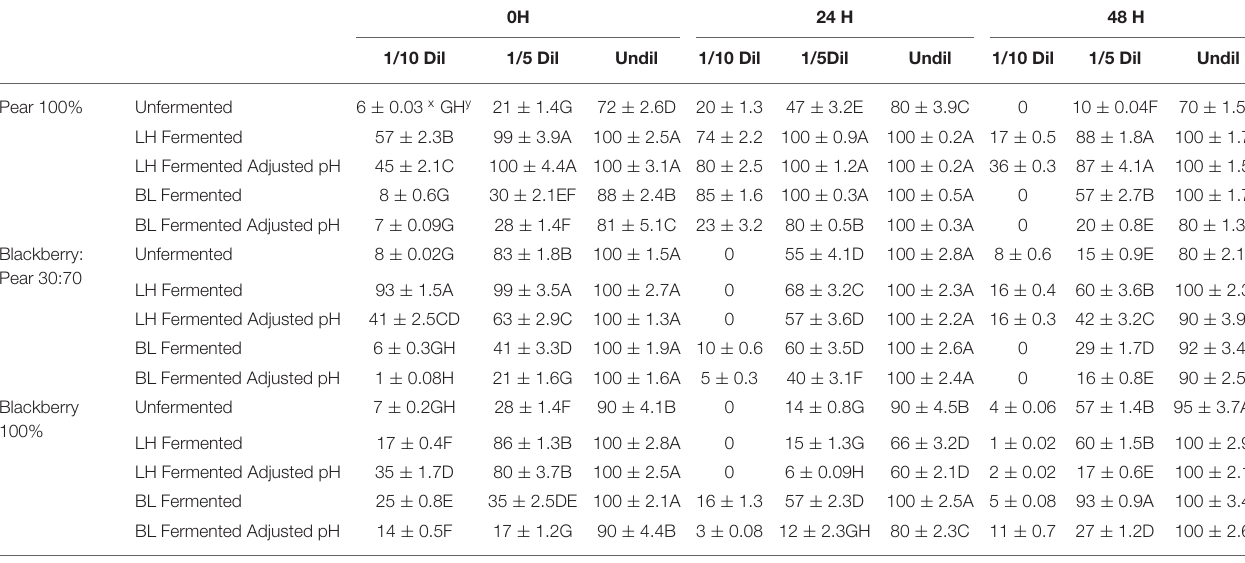
TABLE 3 | Anti-hyperglycemic property relevant α -amylase enzyme inhibitory activity of (1/10th, 1/5th, and undiluted) Bartlett pear (100%), 30:70 (blackberry: pear) combination, and Kiowa blackberry (100%) extracts during (0, 24, and 48h) fermentation with Lactobacillus helveticus (LH) and Bifidobacterium longum (BL). 0H 24 H 48 H 1/10 Dil 1/5 Dil Undil 1/10 Dil 1/5Dil Undil 1/10 Dil 1/5 Dil Undil Pear